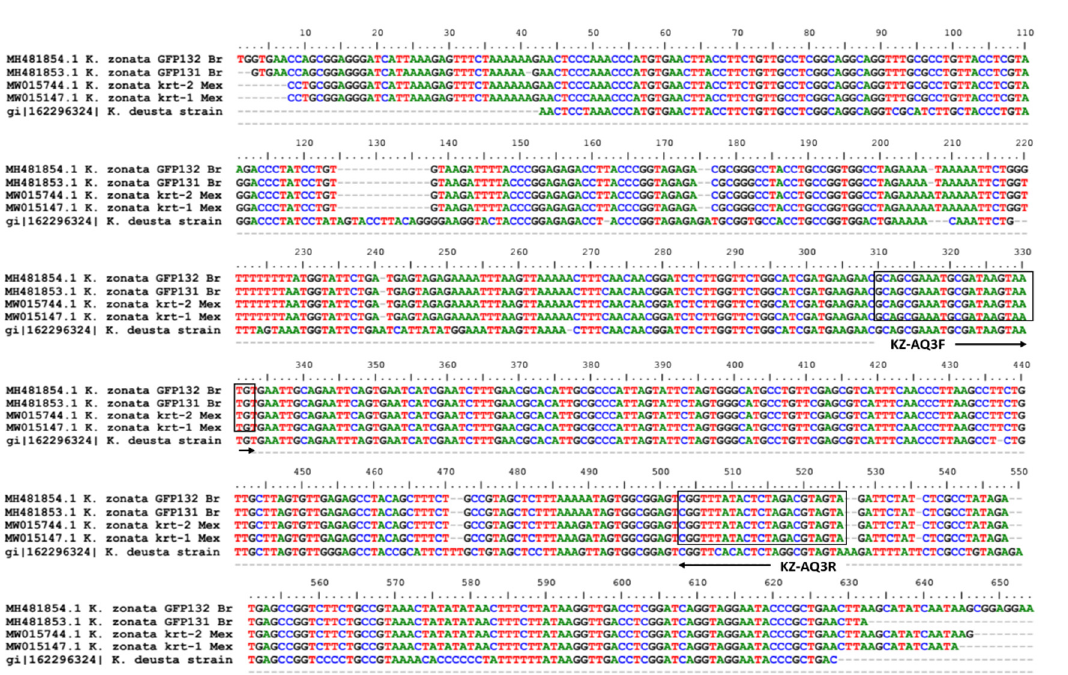
Figure 4. DNA in silico sequence comparison of the internal transcribed spacer (ITS) region between K. zonata from Mexico (MW015147.1, strain krt-1, and MW015744.1, strain krt-2) and from Brazil (MH481853.1, strain GFP131, and MH481854.1, strain GFP132) and K. deusta (EU162067.1, strain 910506.1). The location of the K. zonata species-specific primer set (KZ-AQ-3F and KZ-AQ-3R) sequences are delimited in boxes. In the nucleotide sequence by convention, the colors of the nucleo- tides are: green for adenine, red for thymine, blue for cytosine, and black for guanine.